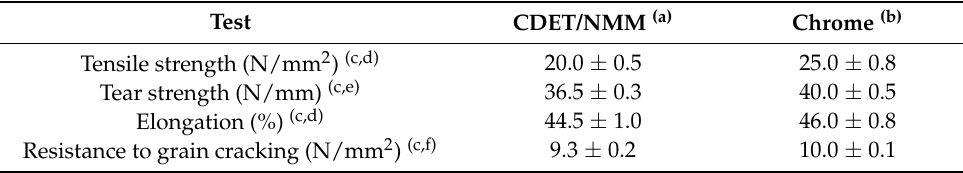
Table 5. Physical-mechanical properties of CDET/NMM and chrome tanned